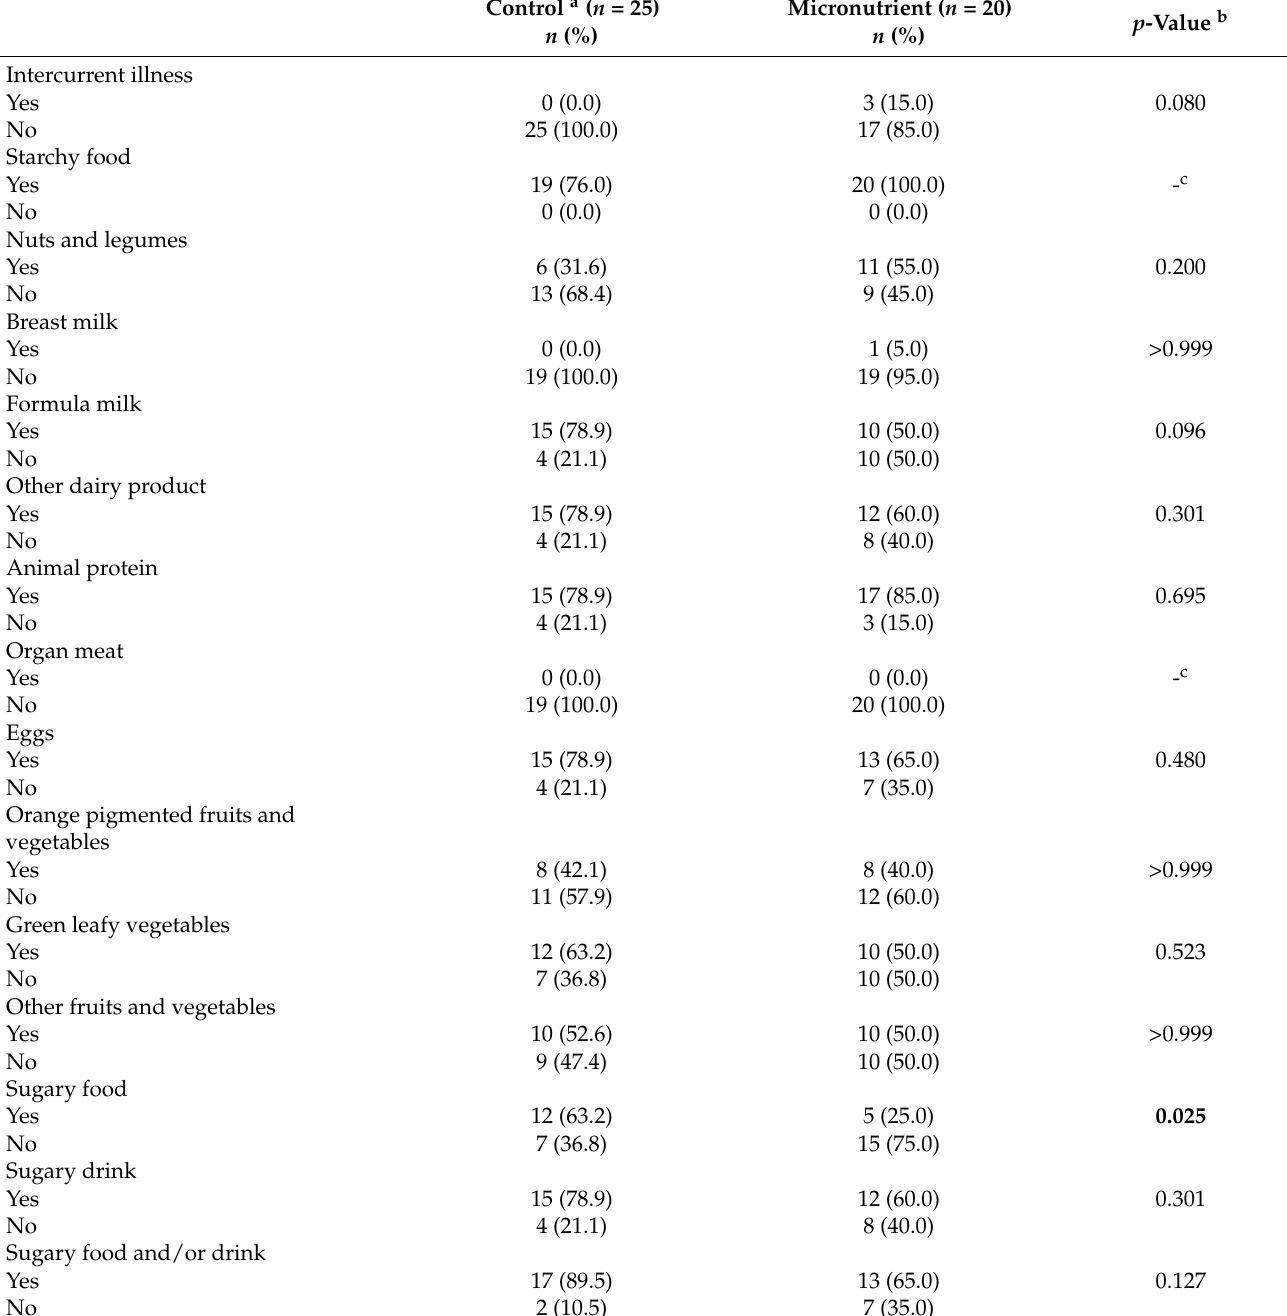
Table 3. Comparisons of dietary groups and clinical endpoints between control and micronutrient groups after 2nd follow-up ( n =